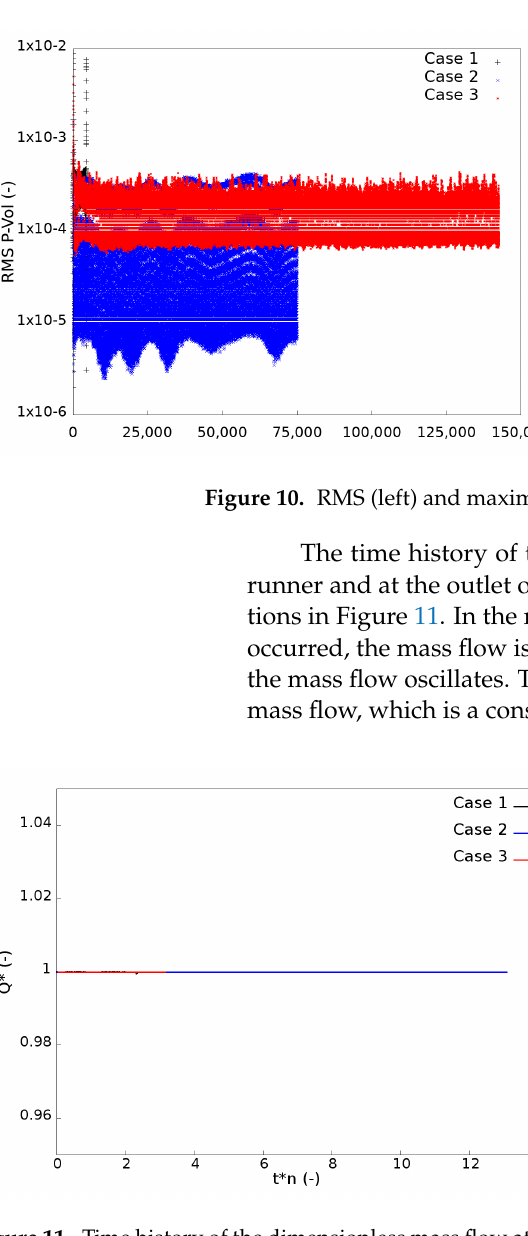
Figure 11. Time history of the dimensionless mass flow at the runner inlet section (left) and at the outlet of the computational domain